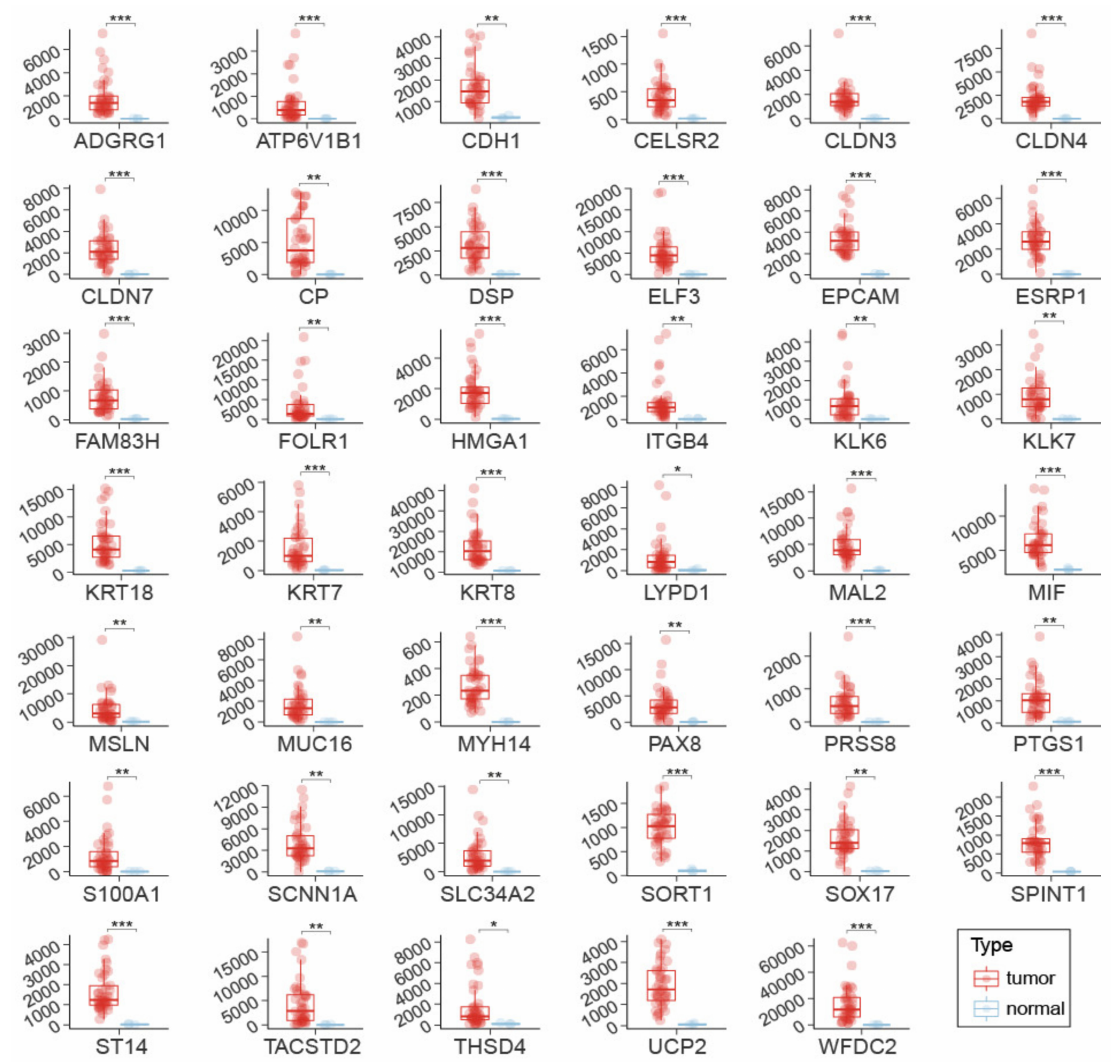
Figure 2. RNA quantification of the 41 putative biomarkers using NanoString nCounter. Gene expression is reported for each of the 41 genes in each of the 42 OSCA tissues (red dots and box plots) and the 3 healthy ovarian tissues (blu dots and box plots). Boxes indicate parameters of RNA quantity distribution (1st quartile, median and 3rd quartile). The statistical significance of the difference in gene expression between the tumor and normal samples was calculated using a non-parametric two-tailed Wilcoxon test (*, p < 0.05; **, p < 0.01, ***, p <